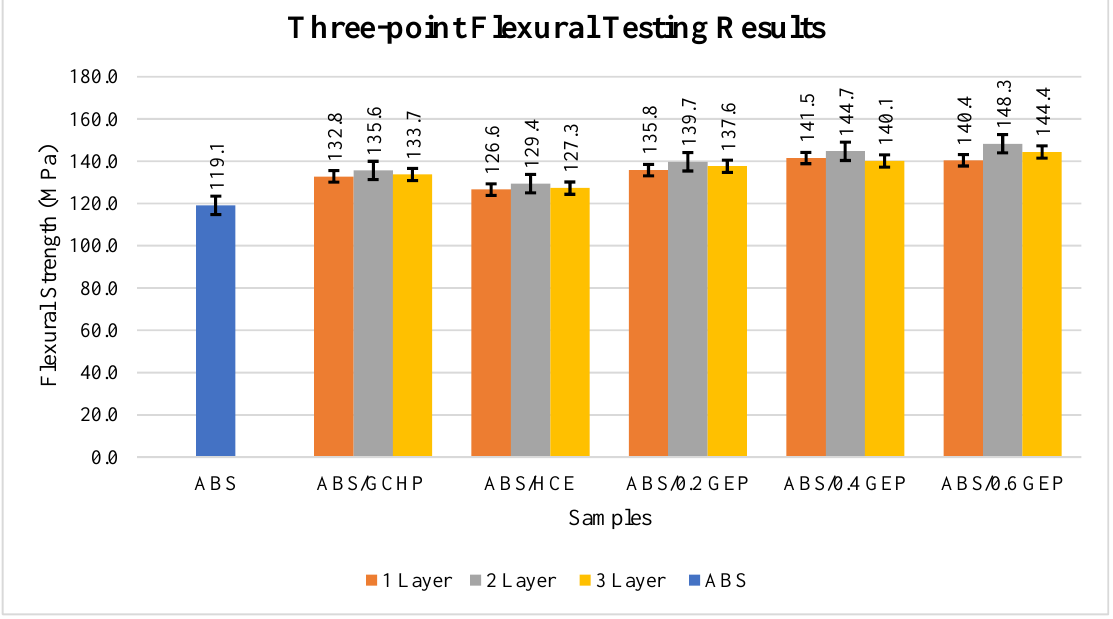
Figure 23. Three-point flexural testing results of ABS-based plastic composites with ABS.